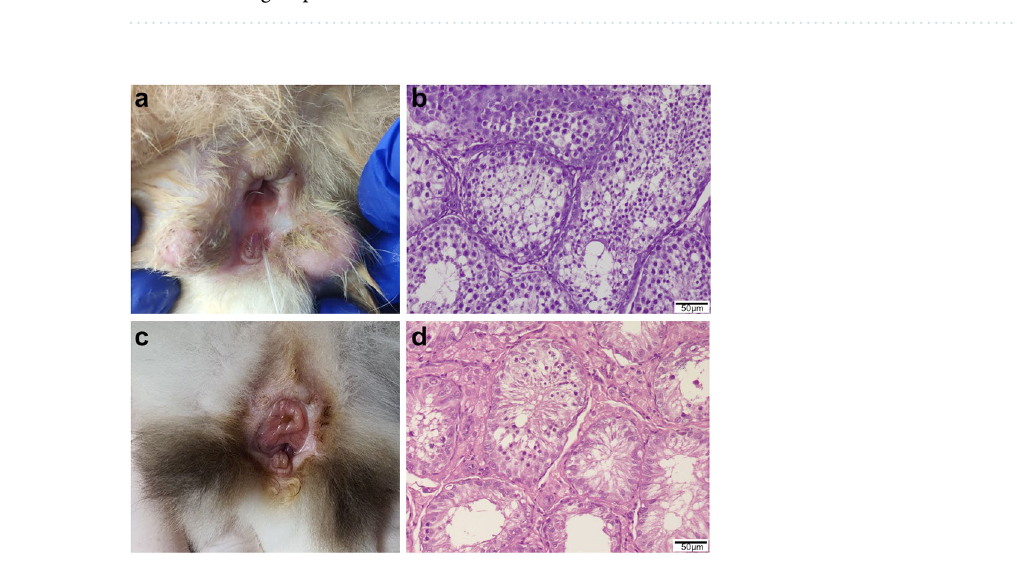
Figure 5. Phenotypes of two DSD cats which were homozygous for the g.70455376delC variant in 5 ′ UTR of the LHCGR gene. Case #7302: ( a ) external genitalia with atypical penis, hypospadias, abnormal mucosa in the perineal area, and bifid scrotum ( b ) histological examination of gonads: numerous seminiferous tubules and Sertoli cells, sperm, and decreased number of Leydig cells; Case #7455: ( c ) external genitalia with abnormal penis, hypospadias, atypical mucosa, and bifid scrotum, ( d ) examination of gonads revealed asymmetrical testes with numerous seminiferous tubules, in larger testis with sperm and in smaller testis without